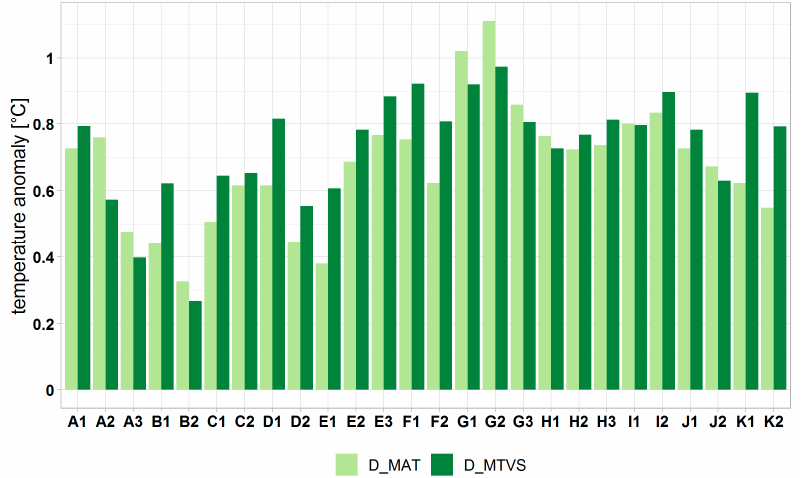
Figure 3. The increases in MAT and MT VS over the last 30 years compared to 1951–1960 decade for the provenance subregions.